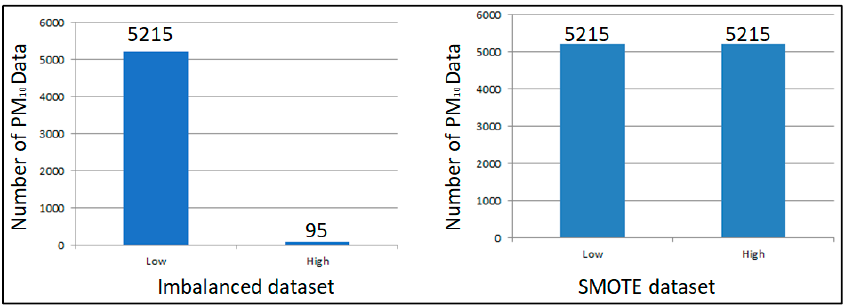
Figure 1. Original dataset vs. synthetic minority oversampling technique (SMOTE) dataset.